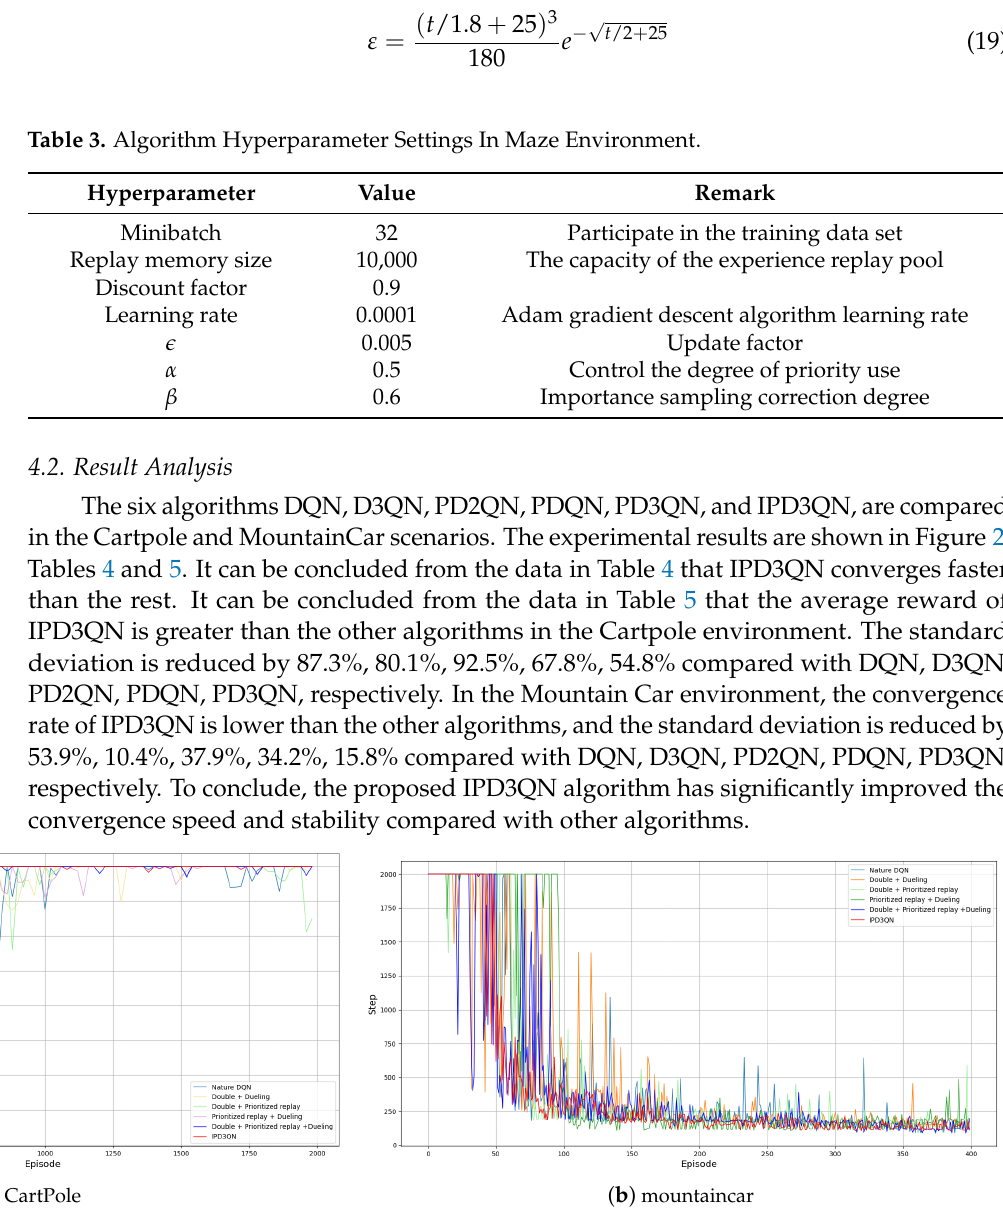
Figure 2. Comparison Of Different Algorithms In Two